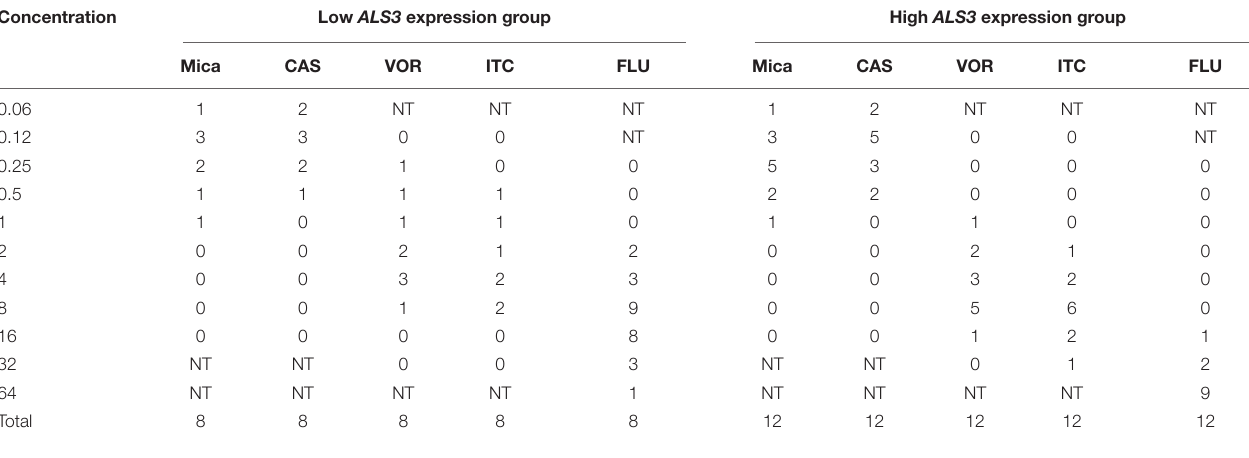
TABLE 3 | The number of strains with MIC50 value of different drugs in the Candida albicans after biofilm formation experiment in mice. Concentration Low ALS3 expression